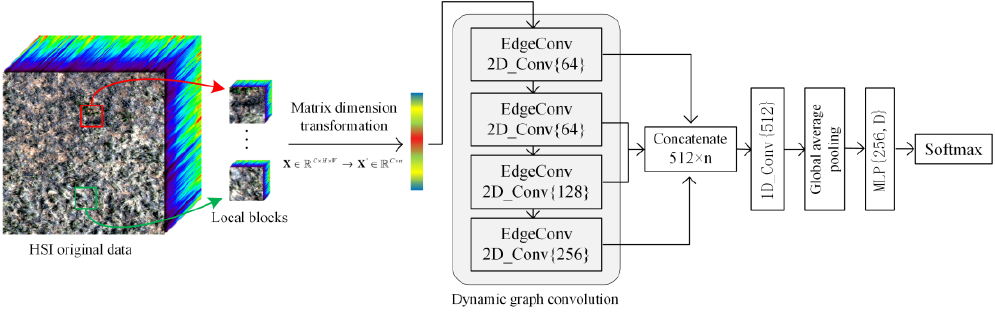
Figure 5. SN_DGCN classification network structure.